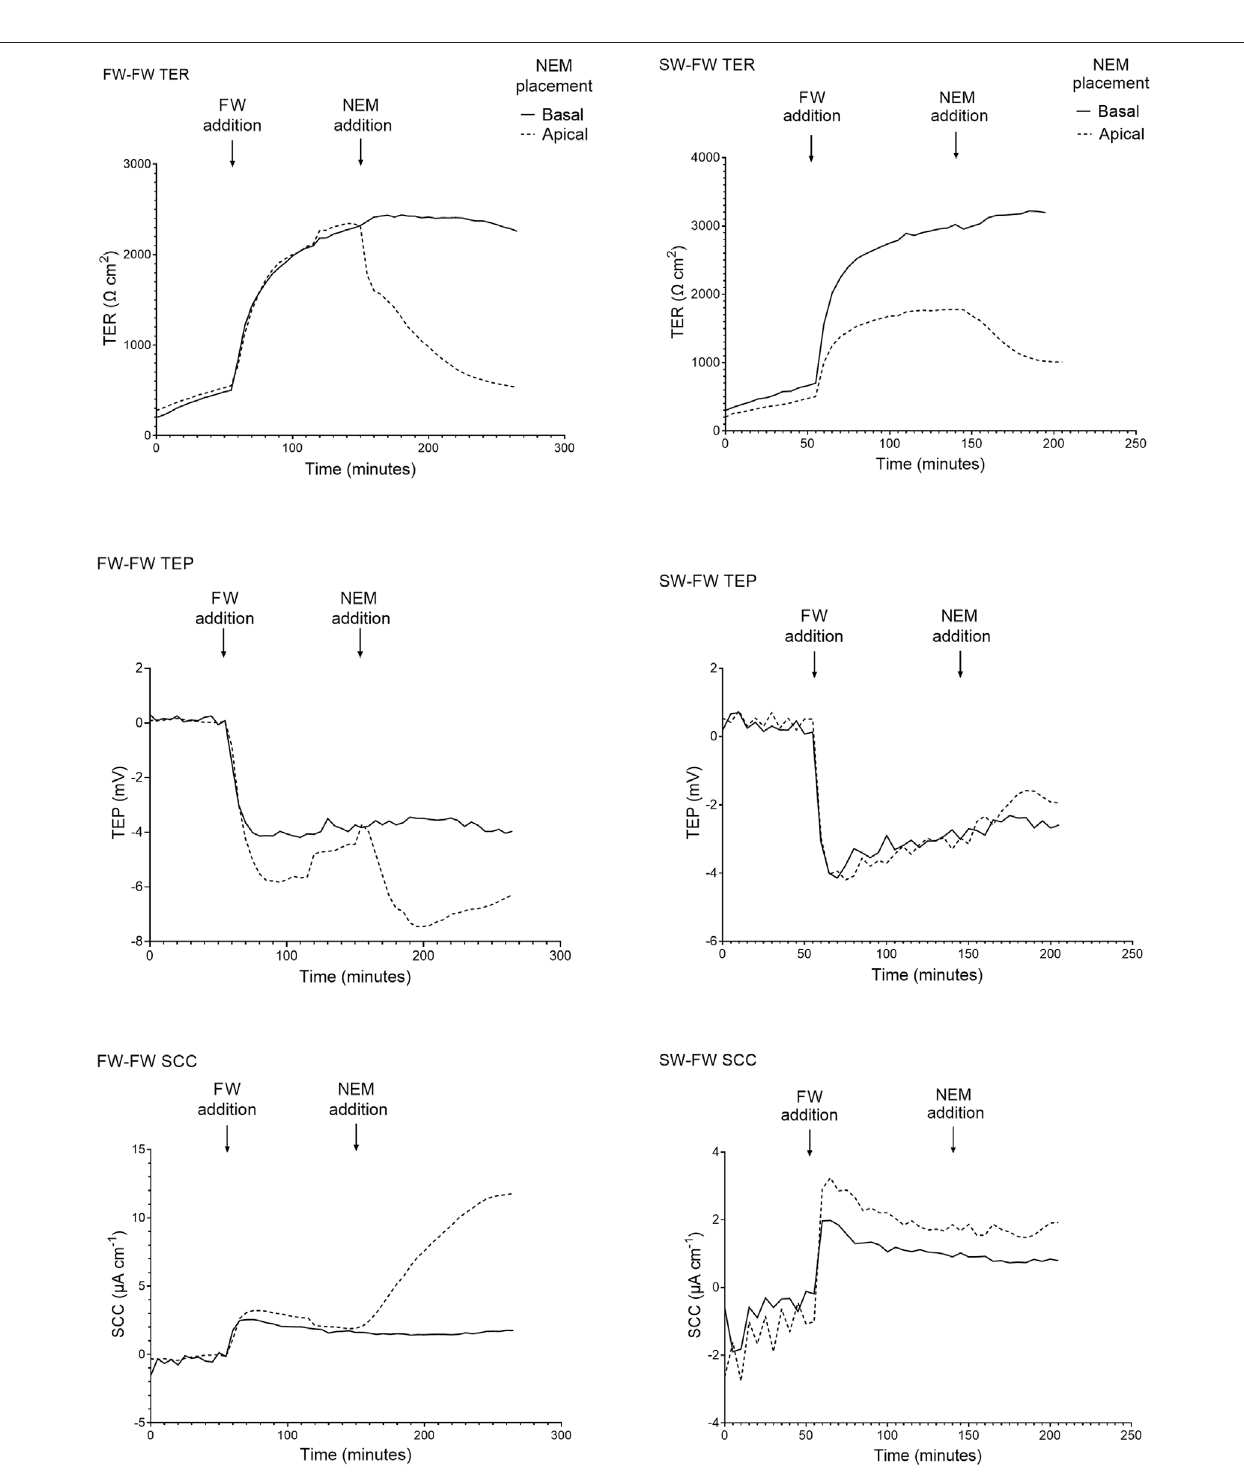
FIGURE 4 | Representative traces of the electrical parameters transepithelial resistance (TER), transepithelial potential (TEP), and short circuit current (SCC) time series of fi sh exposed to FW (FW-FW and SW-FW) in the apical chamber half. A drastic increase in TER can be seen in the FW acclimated fi sh, accompanied by a reduction in TEP. The response to NEM addition is also shown, with a large reduction in TER and a reduction in TEP and SCC (most evident in the FW acclimated skin).